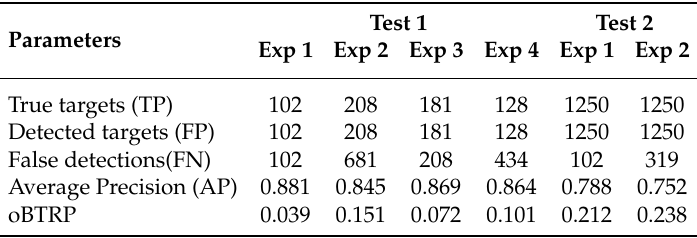
Table 1. Result of the object detection in 6 experiments, Test 1: Experiment 1 (P900-130